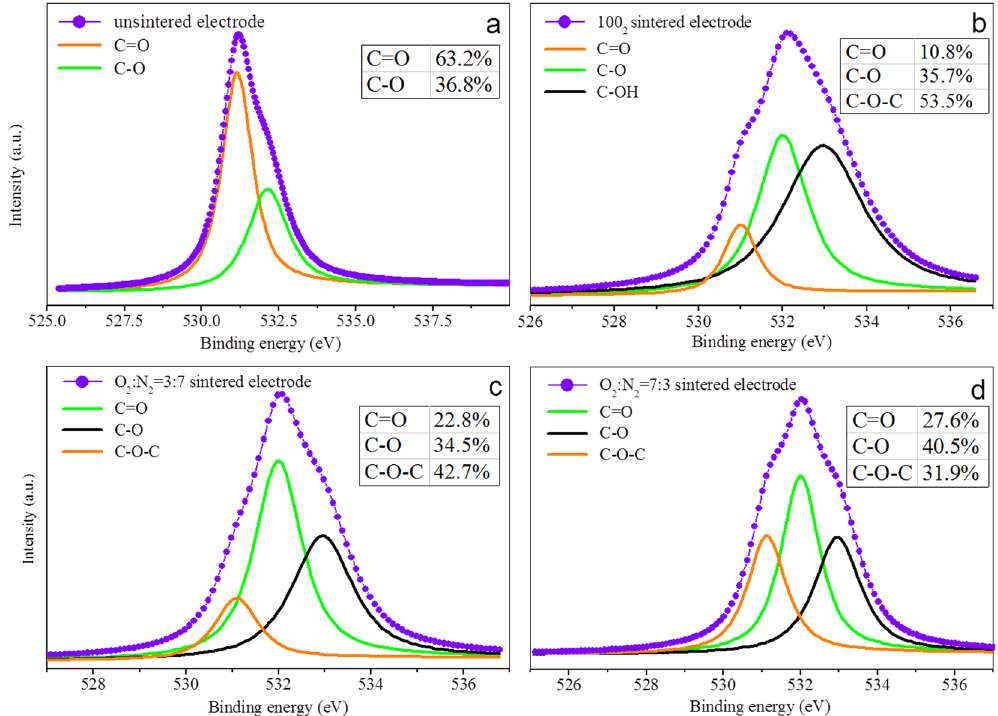
Figure 3. The high resolution O1s spectra of newly fabricated CB electrodes with different